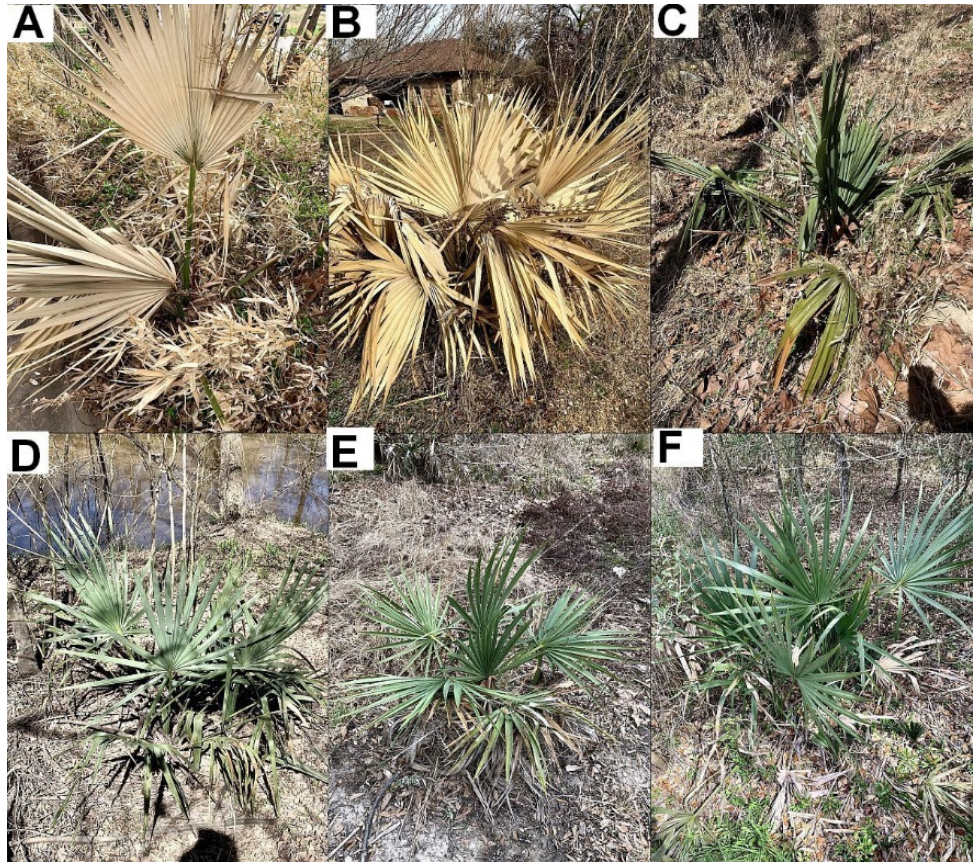
Figure 2. This figure shows typical examples of Sabal minor at each of the six locations after the passage of Winter Storm Uri. At the Oklahoma City Zoo ( A ) and the private residence in Choctaw ( B ), both in central Oklahoma, palms were a median of <5% green after temperatures dropped to − 26 °C and remained below freezing for 11 days. At Beavers Bend State Park in McCurtain County, Oklahoma ( C ), where temperatures dropped to − 21 °C and stayed below freezing for approximately seven days, leaves were a median of 85% green. Palms at the nearby Red Slough Wildlife Management Area ( D ), which experienced similar conditions, remained approximately 90% green. Lick Creek Park ( E ) in Brazos County, Texas, and Bobcat Woods at San Bernard National Wildlife Refuge ( F ) in Brazoria County, TX, showed similar amounts of green to palms in southeastern